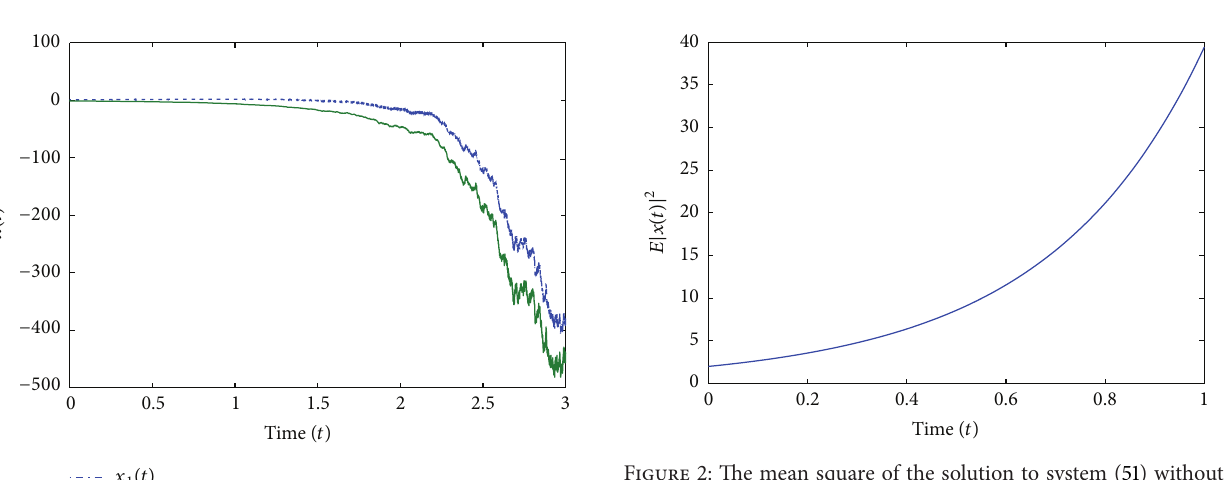
Figure 2: The mean square of the solution to system (51) without impulses (2000 samples).